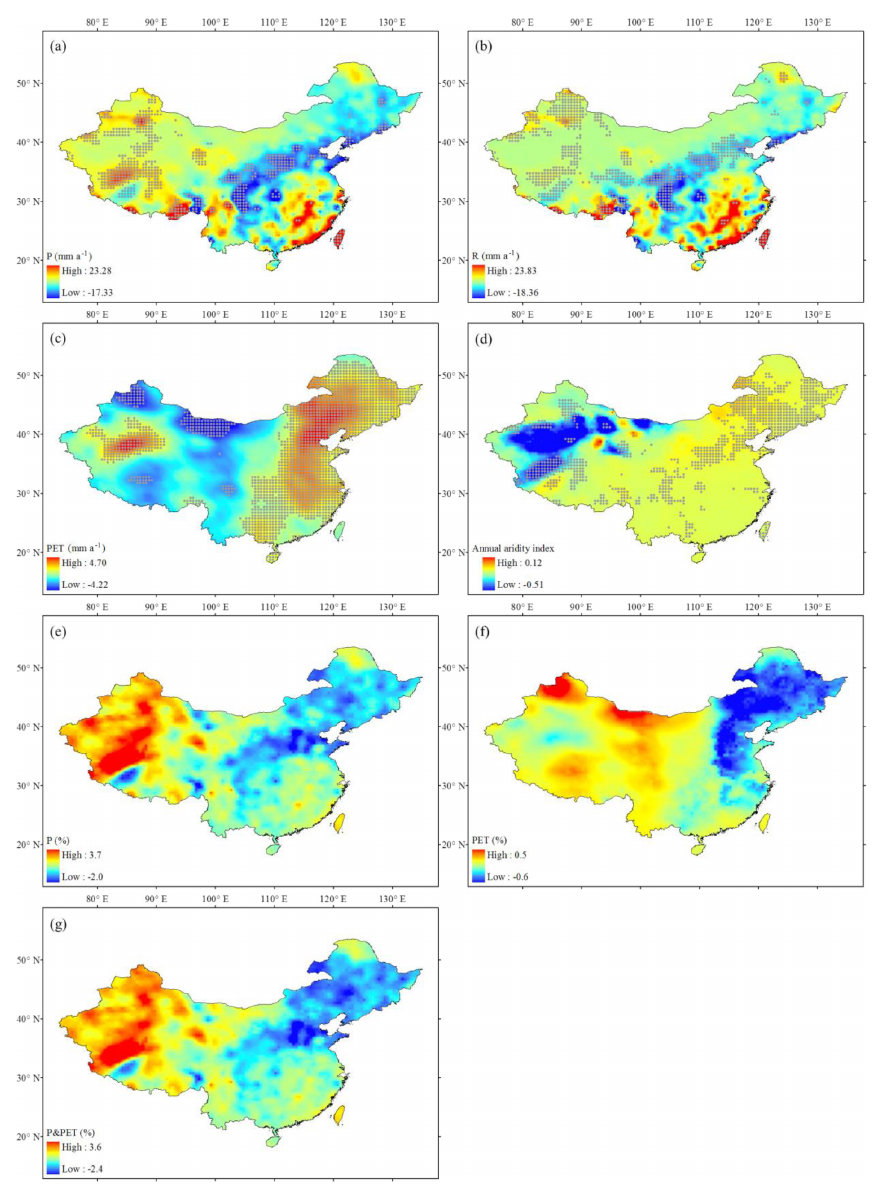
Figure 8. Trend magnitudes in annual time series of (a) P , (b) R , (c) PET, and (d) aridity index for the period 1960–2008 and spatial distributions of the contributions (unit: %yr − 1 ) of (e) P , (f) PET, and (g) climate (i.e. P and PET) to R in China for the period 1960–2008. The trend magnitudes are estimated by Sen’s method. Grey dots are shown as statistically significant positive/negative trends ( p <